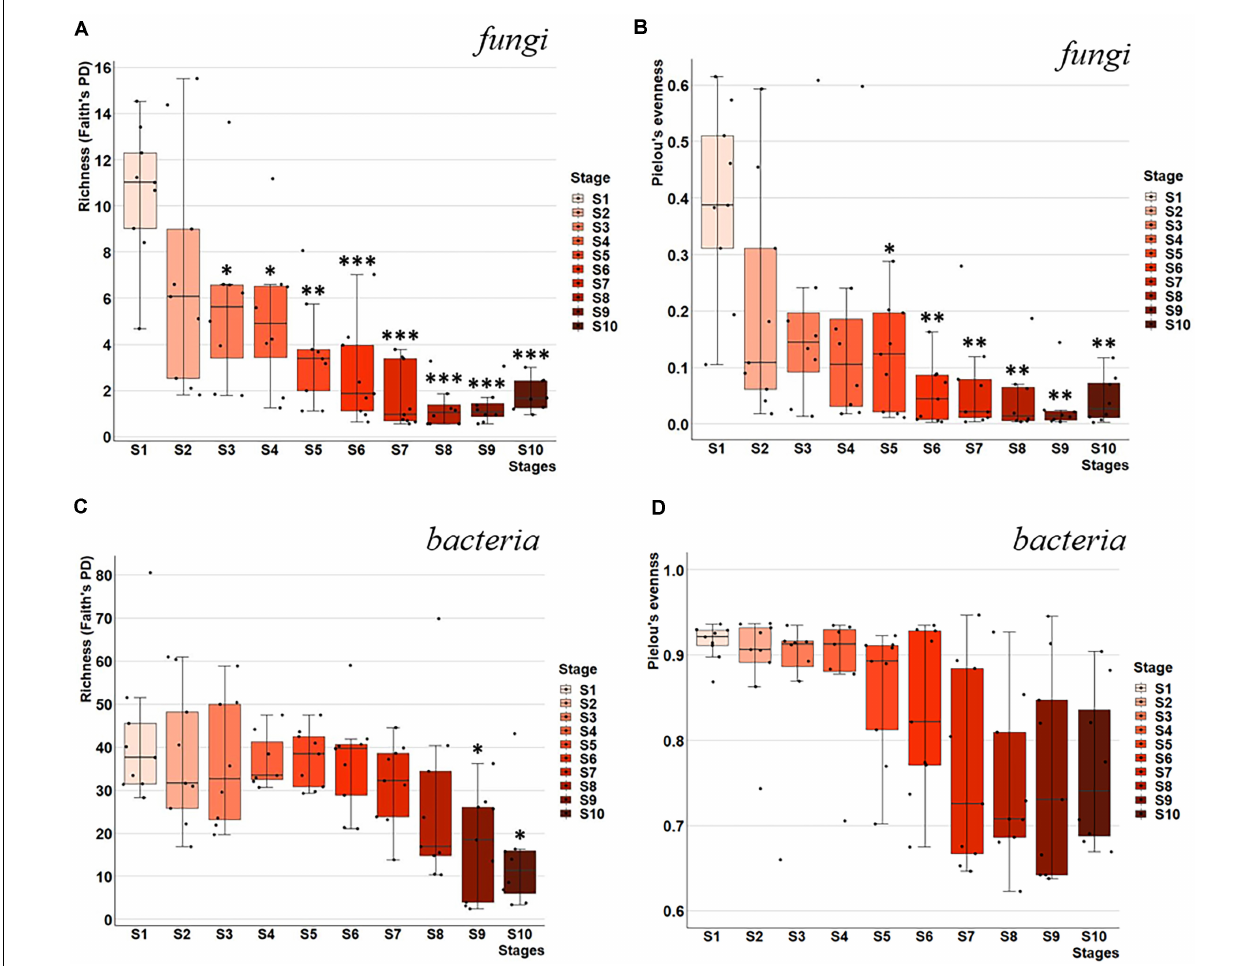
FIGURE 2 | Microbial richness and evenness throughout fermentation stages of Chambourcin red wine. Rarefied alpha diversity distribution of microbial richness and evenness throughout fermentation stages for samples collected across nine wineries and ten fermentation stages. Faith’s phylogenetic diversity (PD) of richness for (A) fungal and (C) bacterial communities, and Pielou’s evenness for (B) fungal and (D) bacterial communities. Box plots represent the 1.5*IQR (Inter quartile range) divided by the square root of n, which corresponds to the 95% confidence interval. Significant differences between fermentation stages relative to stage 1 were determined using Kruskal–Wallis test with FDR-adjusted p -value ( q -value). * q -value < 0.05, ** q -value < 0.01, and *** q -value <